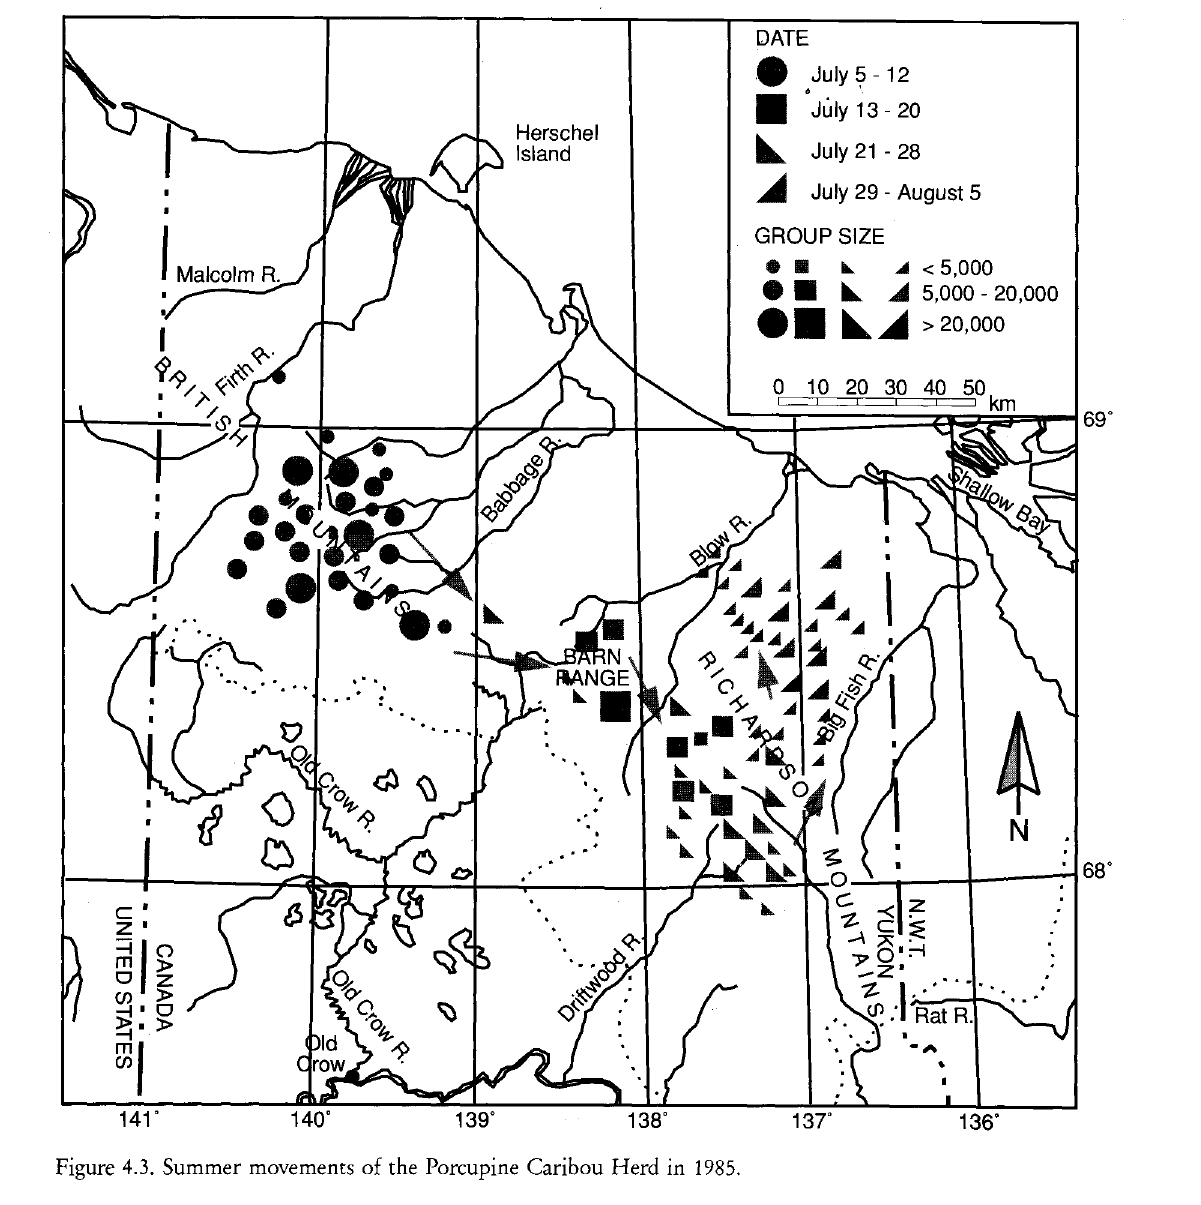
Figure 4.3. Summer movements of the Porcupine Caribou Herd in